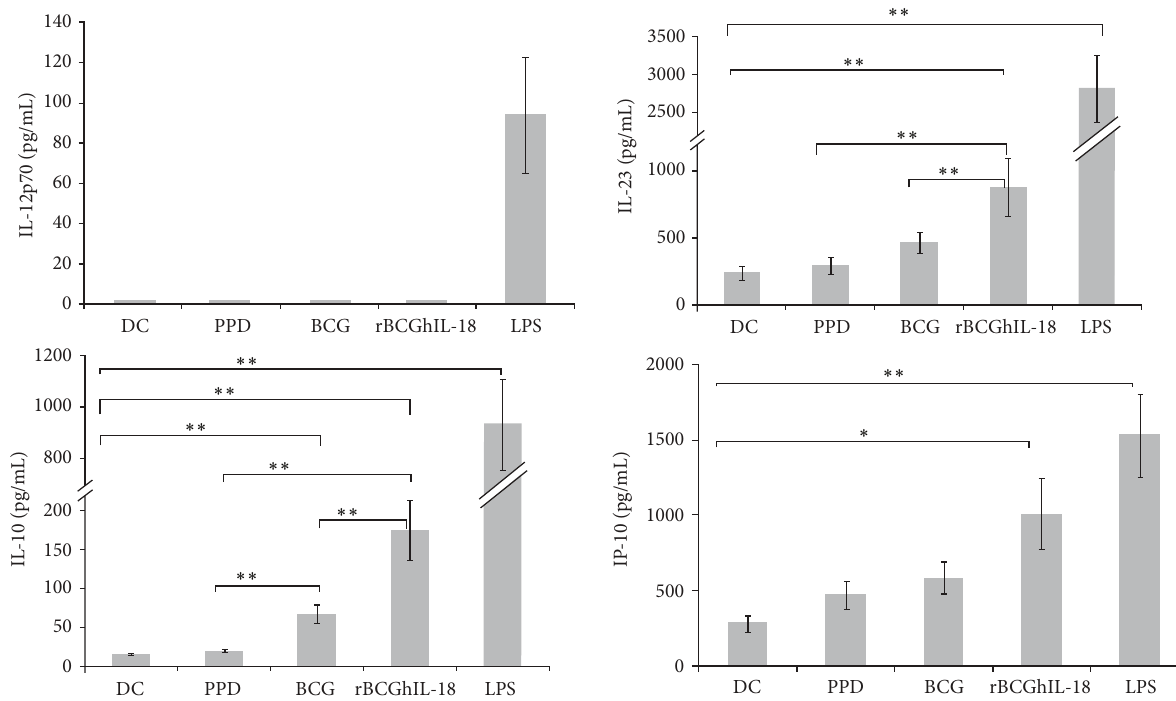
Figure 6: IL-12p70, IL-10, IL-23, and IP-10 production by stimulated MoDCs. Human MoDCs were stimulated with PPD (10 𝜇 g/mL), BCG (1:1), rBCGIL-18 (1:1), or LPS (1 𝜇 g/mL) for 24 h or were left untreated (DC). The cytokine and chemokine levels in the culture were measured by ELISA. Data shown are the mean ± SEM of 40 independent donors. Statistical analyses were performed using the Kruskal-Wallis test. ∗ 𝑃 < 0.05 ; ∗∗ 𝑃 < 0.01